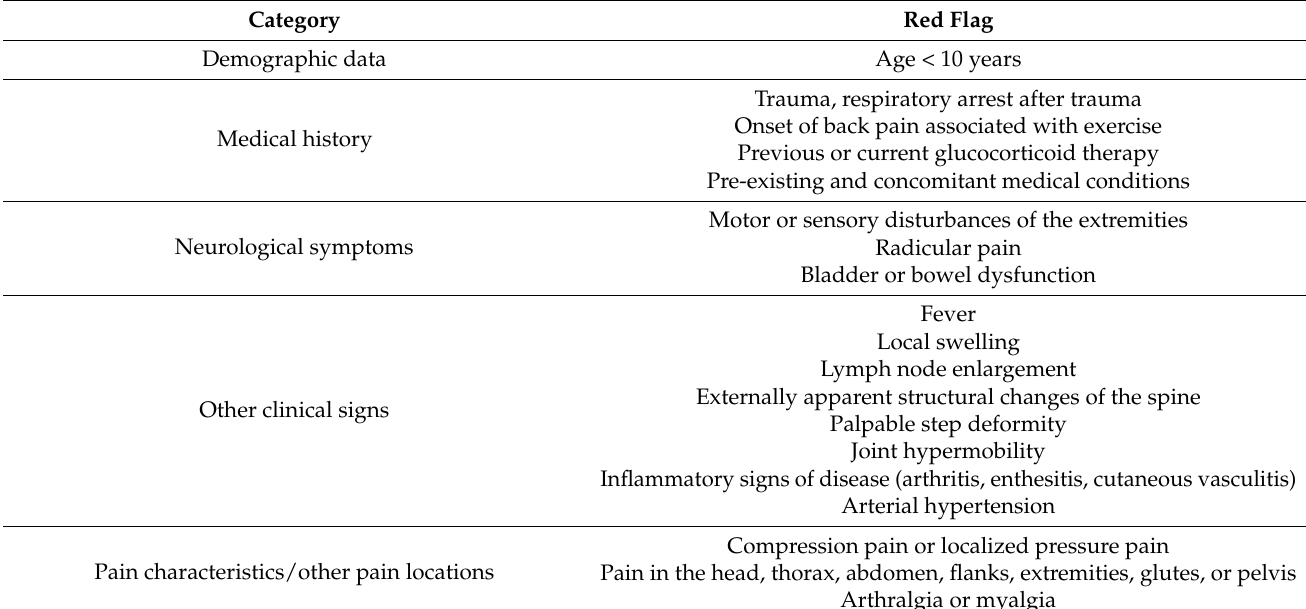
Table 1. Red flags for specific back pain in children and adolescents.